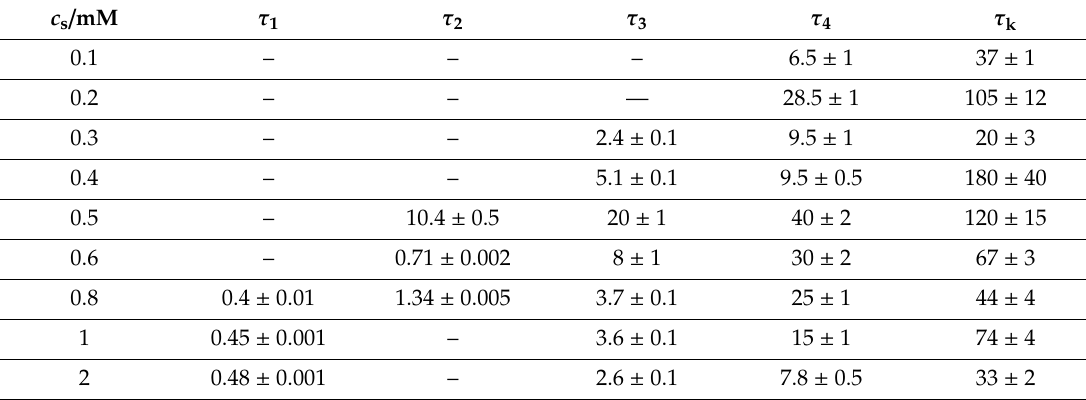
Table 2. Characteristic times, in seconds, found in dynamic surface tension for all surfactant concentrations